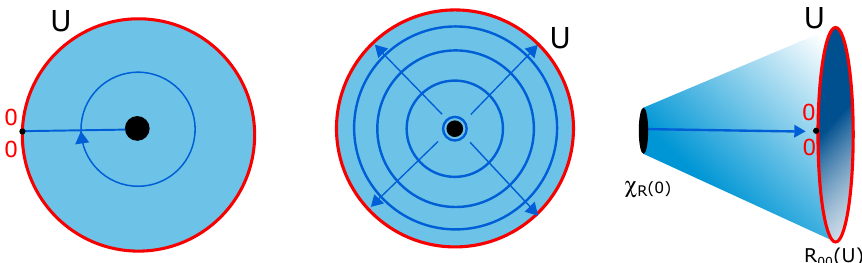
Figure 2 . Left: angular slicing of the amplitude. Middle and Right: circular slicing and annular region connecting the inner boundary and the outer, the latter projecting on the invariant indices. From hereon coset boundaries will always we depicted in